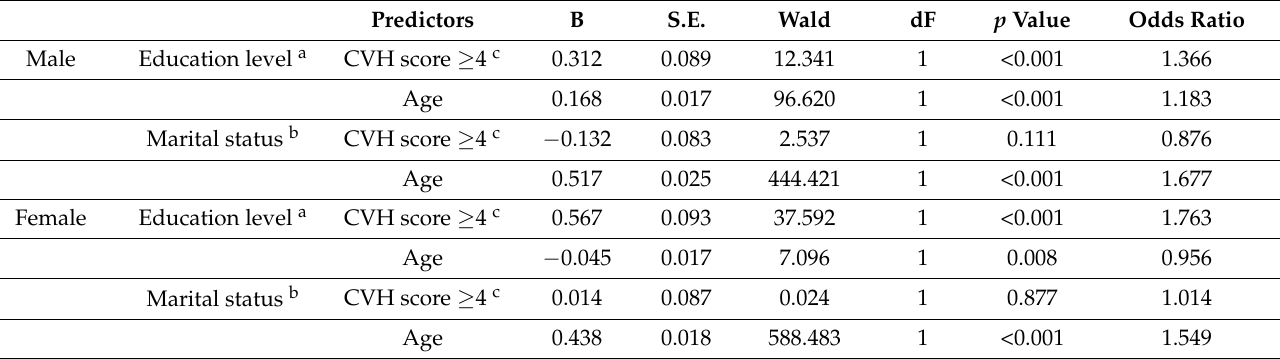
Figure 2. Early changes in female’ CVH metrics by education level and marital status. Table 5. Logistic regression models of educational level and marital status.